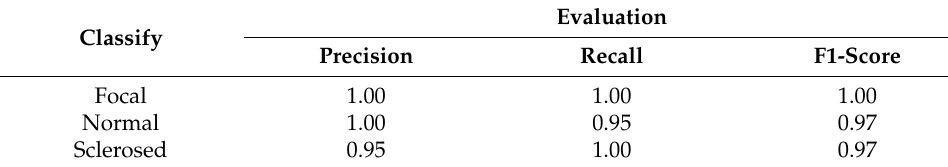
Table 6. Classification of Resnet101V2.